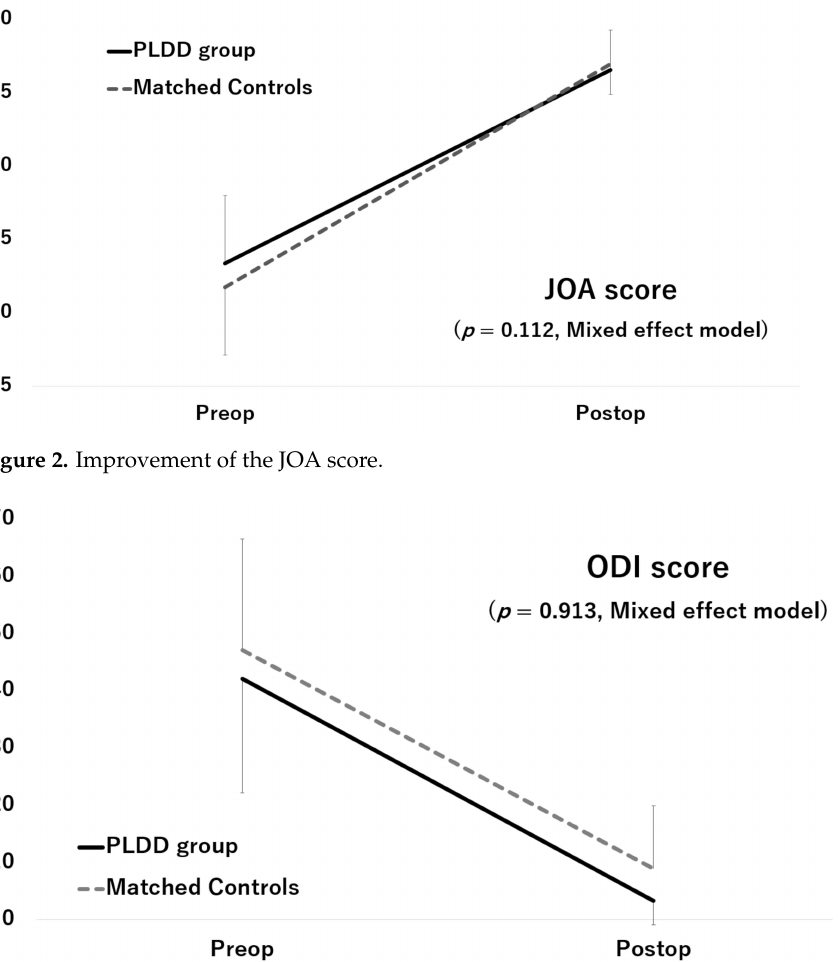
Figure 3. Improvement of the ODI